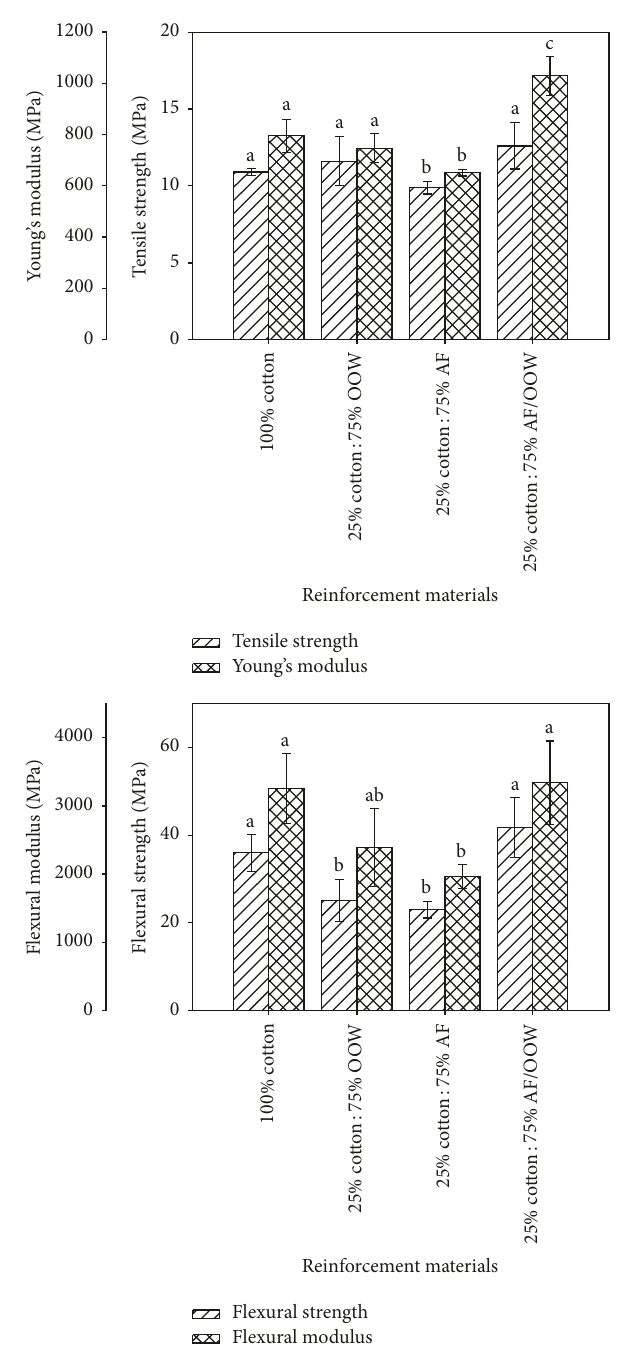
Figure 6: The influence of various reinforcements of composites on their mechanical properties. Treatment values with different letters for the same mechanical test are significantly different ( 𝑝 ≤ 0.05 ) following Duncan’s Multiple Range Test